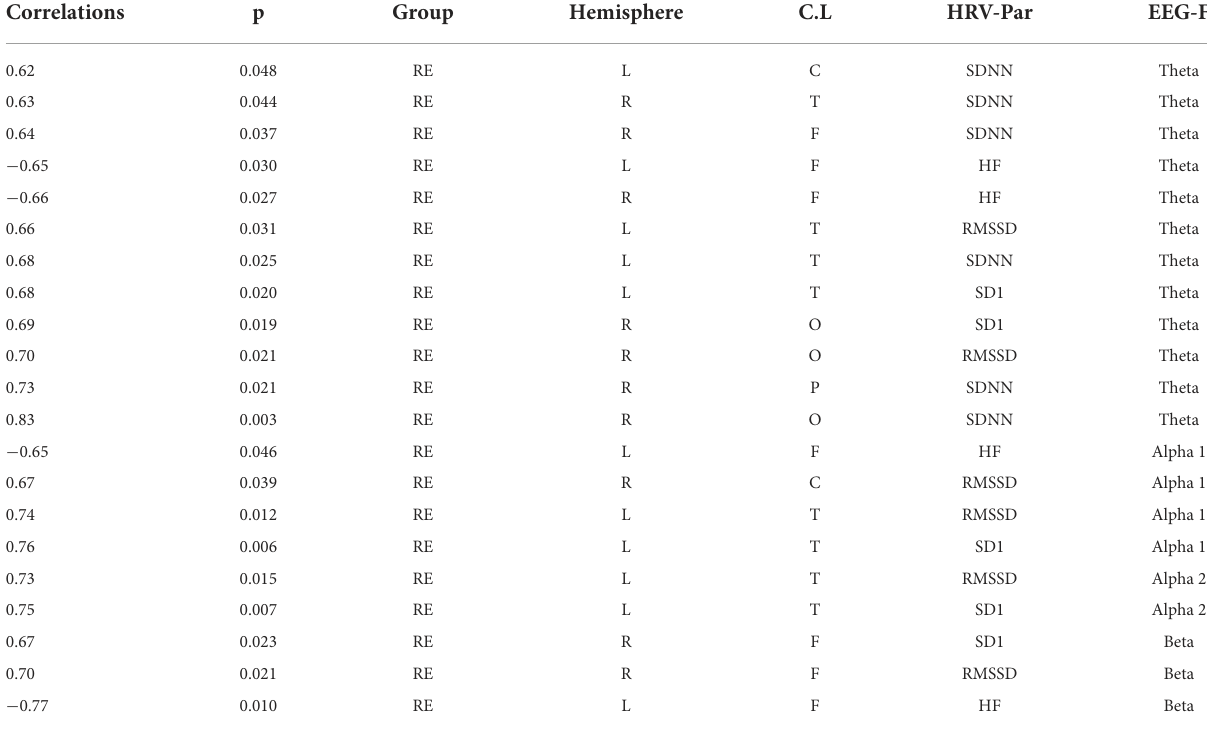
TABLE 2 Spearman correlations calculated between EEG power and HRV parameter for the refractory epilepsy group. Correlations p Group Hemisphere